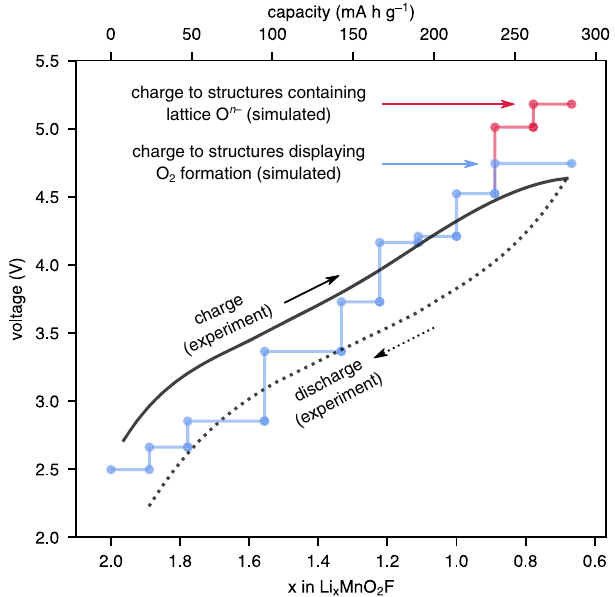
Fig. 5 | Experimental and calculated voltage curves. The calculations are based on charging to structures containing lattice O n – , or to a structure containing O 2 , compared against the experimental fi rst-cycle voltage-capacity curve from galva- nostatic intermittent titration technique (GITT)